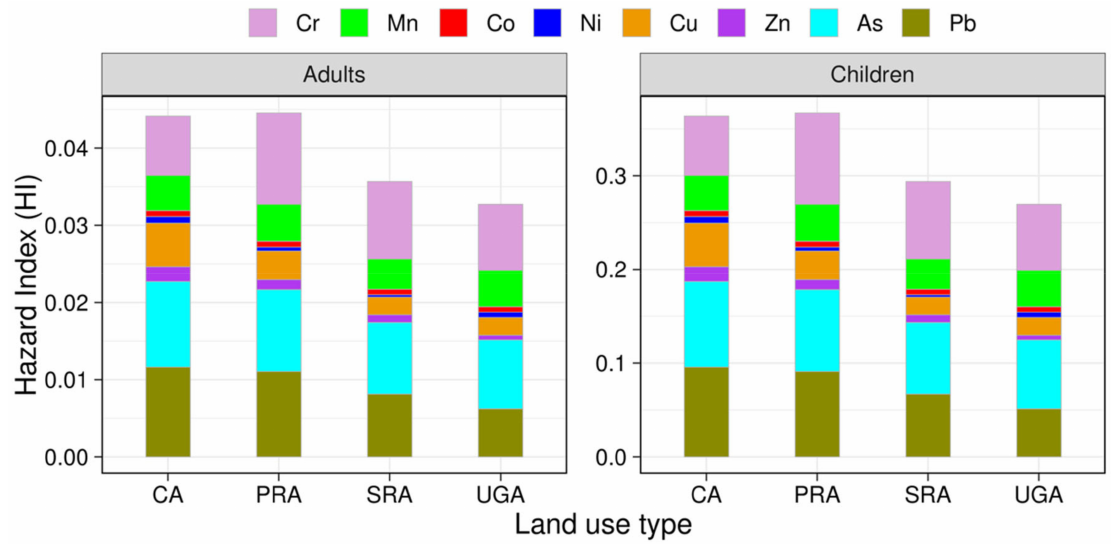
Figure 5. Hazard quotient (HQ) and hazard index (HI) of toxic metals for adults and children in different land-use areas in Dhaka city. CA = commercial area, PRA = planned residential area, SRA = spontaneous residential area, UGA = urban green